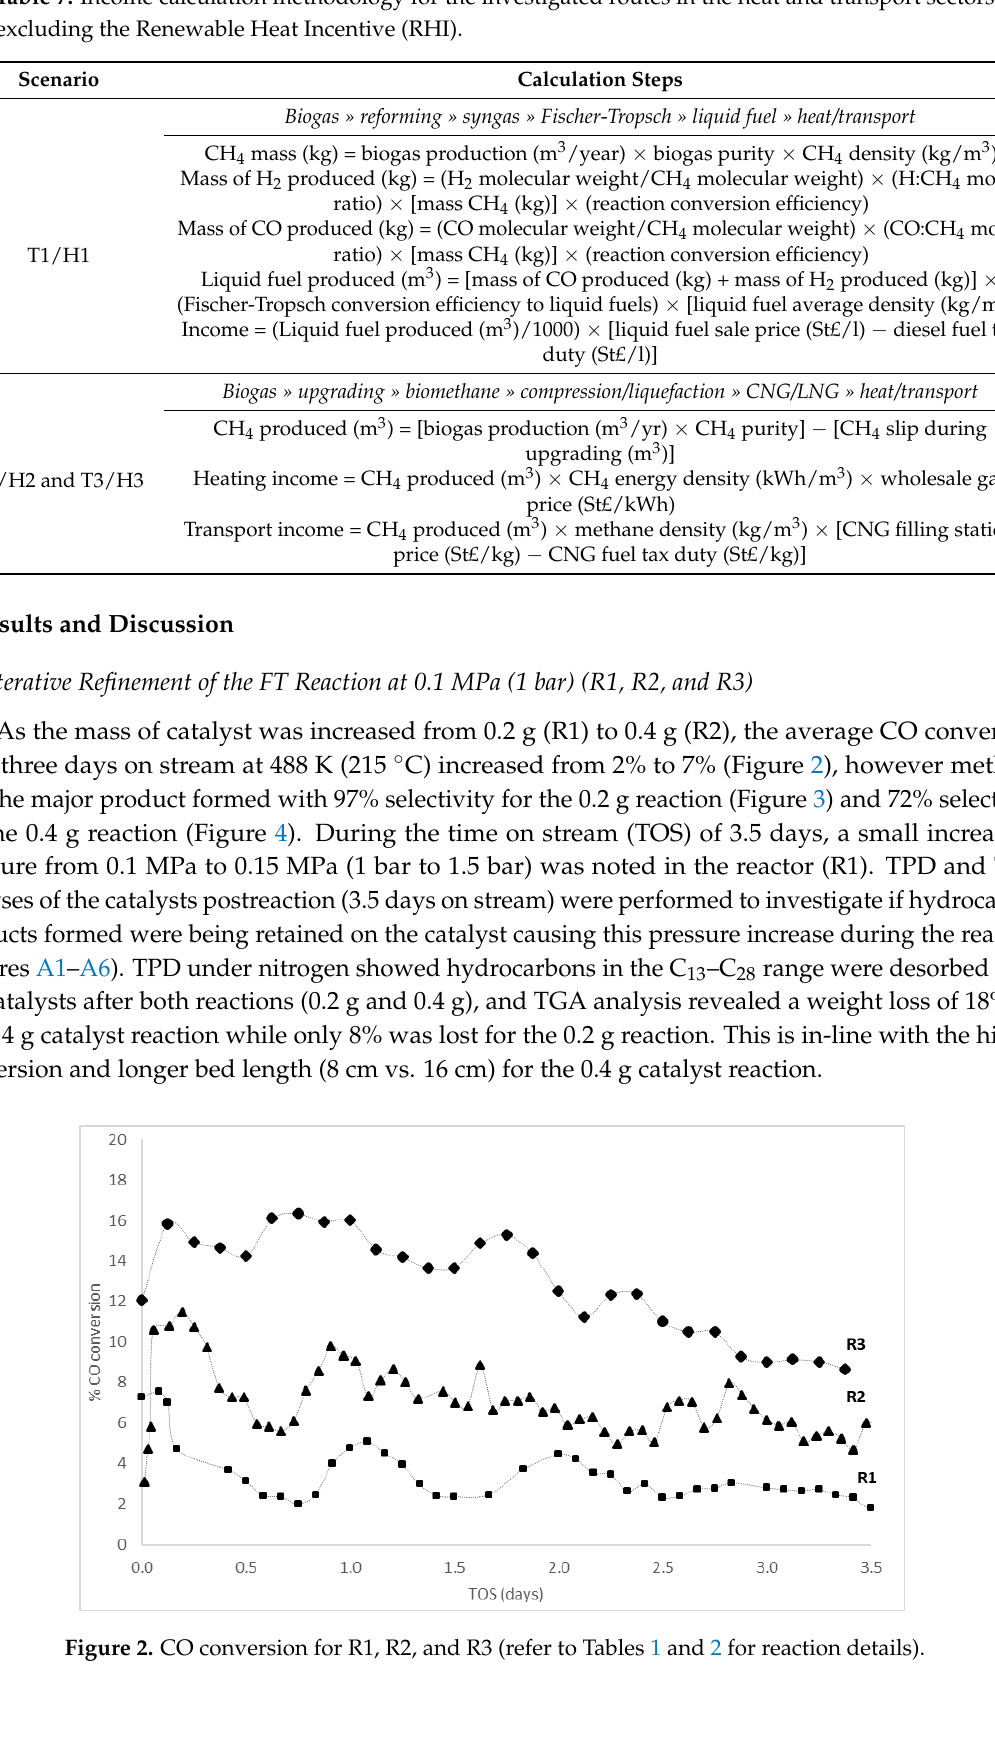
Figure 3. R1 product selectivity (refer to Tables 1 and 2 for reaction details). Figure 4. R2 product selectivity (refer to Tables 1 and 2 for reaction details).